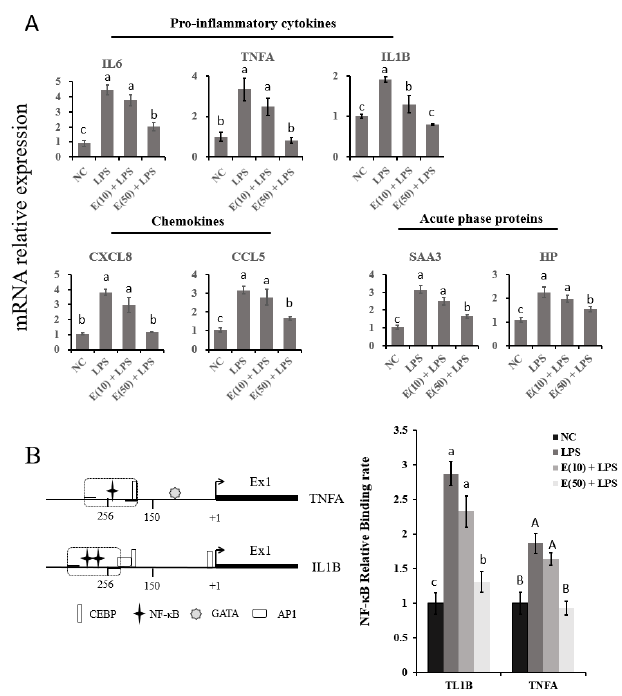
Figure 4. The expression of pro-inflammatory genes and binding activity of NF- κ B subunit p 65. The concentration and timing of EGCG treatment to cells were selected as 24 h at a concentration of 10 µ M or 50 µ M. ( A ) The mRNA expression of pro-inflammatory cytokines, chemokines, and acute-phase-protein-encoding genes. Abundance of each gene was normalized by the geometric mean of the internal control genes ( GAPDH , UXT, and RPS9 ). Abundance of genes in the NC group was set as 1.0. ( B ) Numbers refer to the position relative to the transcriptional starting site, indicated by black arrows. The position of the transcription factors is indicated by the respective symbols. The positions of primers used for chromatin immunoprecipitation assays are denoted by dashed lines surrounding the symbol of NF- κ B. The identification of target promoter regions of candidate genes was determined by BLAST analysis as DNA-sequences that are 5 ′ -upstream of the mRNA sequences deposited in the NCBI: NM_174093.1 ( IL1B ); NM_173966.3 ( TNFA ). Level of NF- κ B binding to IL1B and TNFA promoter. Letters in lowercase indicate differences between groups for IL1B , while uppercase indicate differences between groups for TNFA ( p < 0.05). Results are expressed as means ± S.E.M.